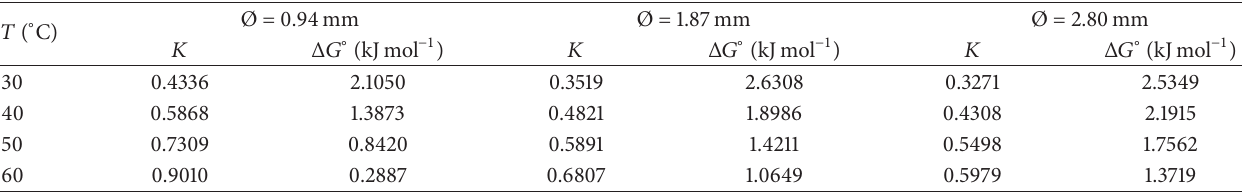
Table 6: Partition coefficient ( 𝐾 ) and variation of Gibbs free energy ( Δ𝐺 ∘ ) of the oil extraction process from Jatropha seeds with moisture content of 8.73% for different temperatures and particle sizes using ethanol as a